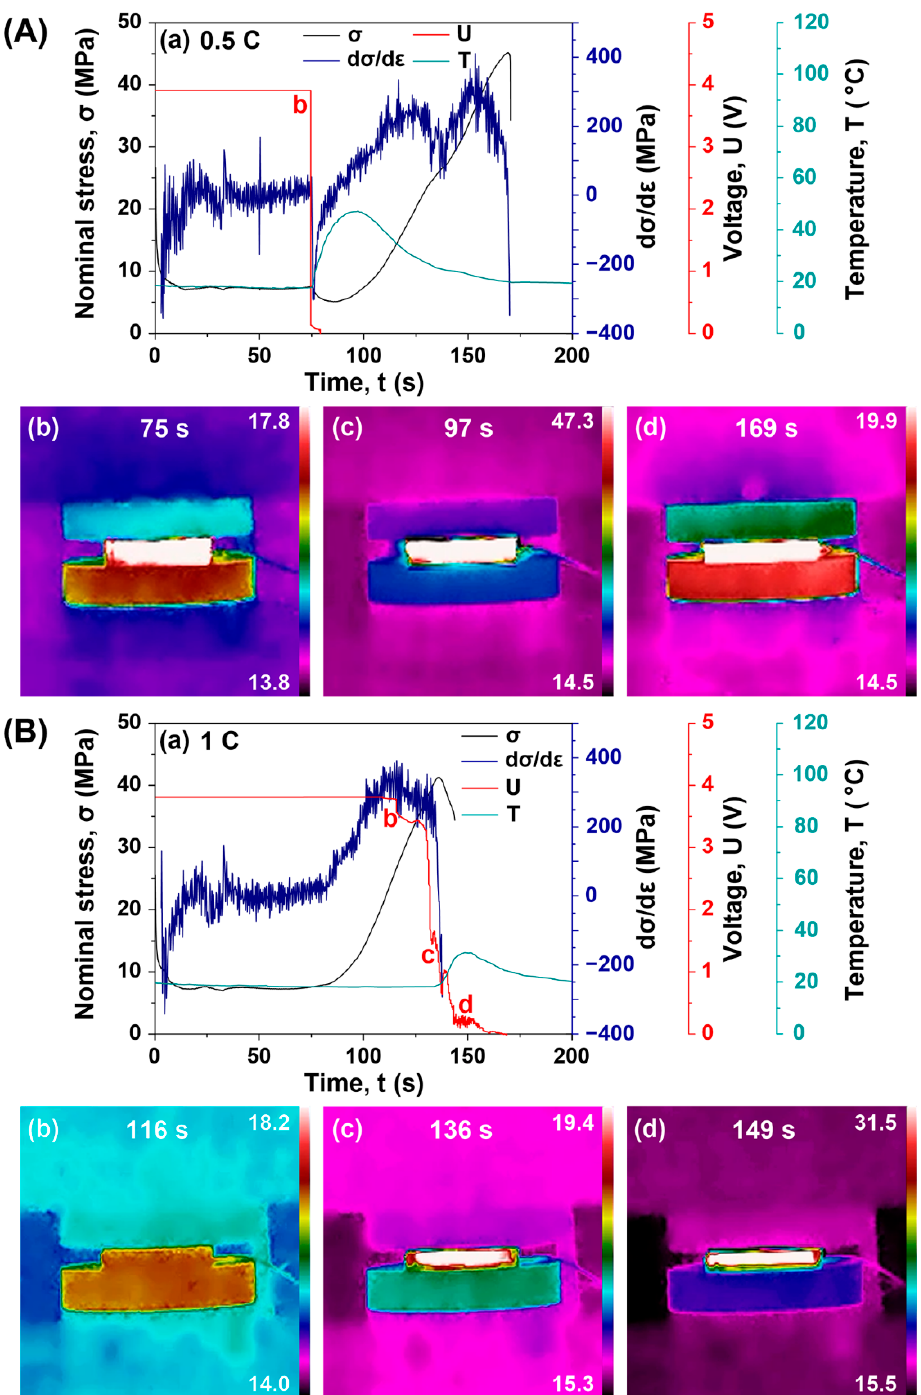
Figure 3. ( a ) The nominal stress-time, nominal modulus-time, voltage-time, and surface temperature-time curves in compression of the 18650 lithium-ion ba tt ery cells charged at − 25 °C, and ( b – d ) their time-stamped thermal images: the cells ( A ) at 0.5 C and ( B ) at 1 C.